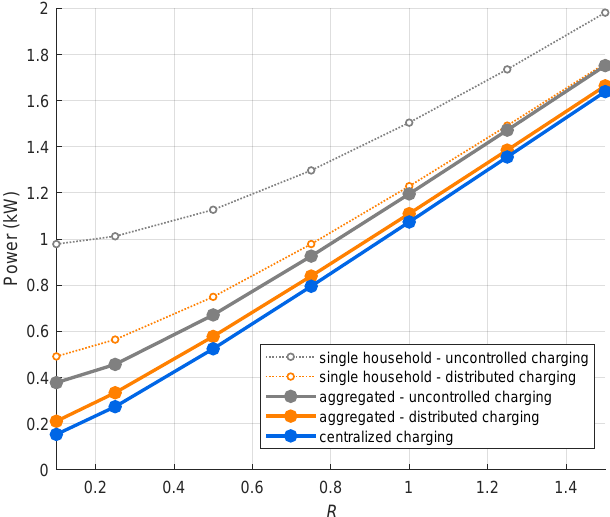
Figure 9. Net load standard deviation per household against production-to-consumption ratio R